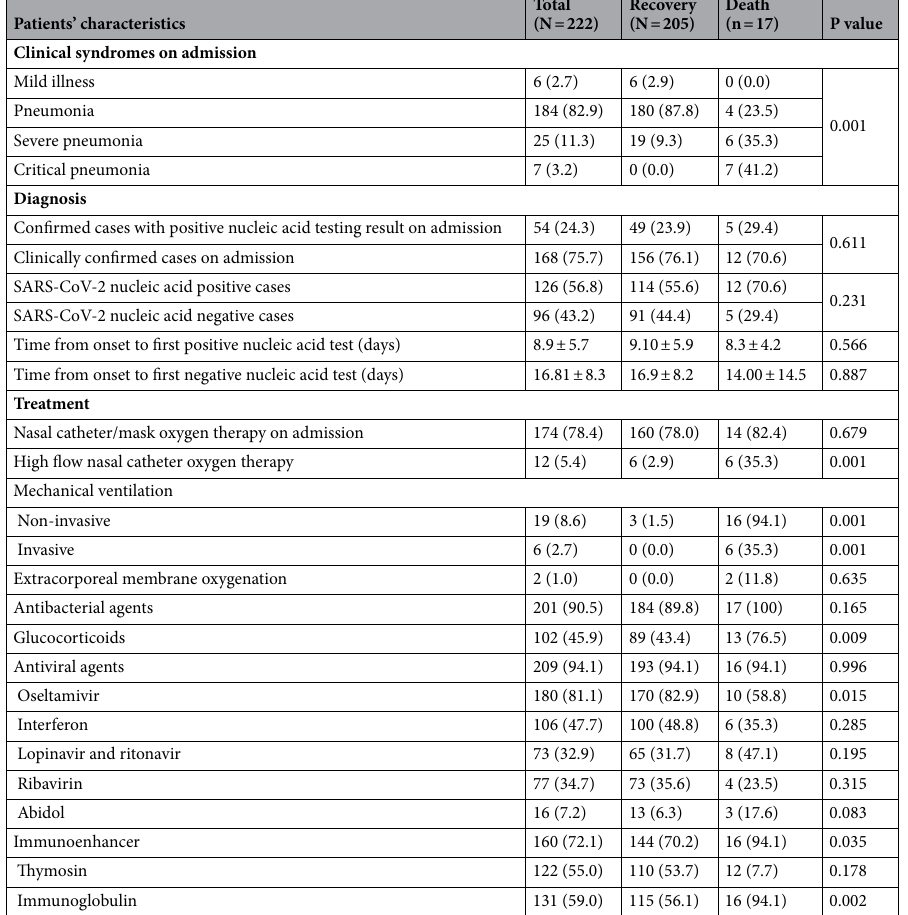
Table 1. Clinical features for 222 COVID-19 patients of different terminal prognosis